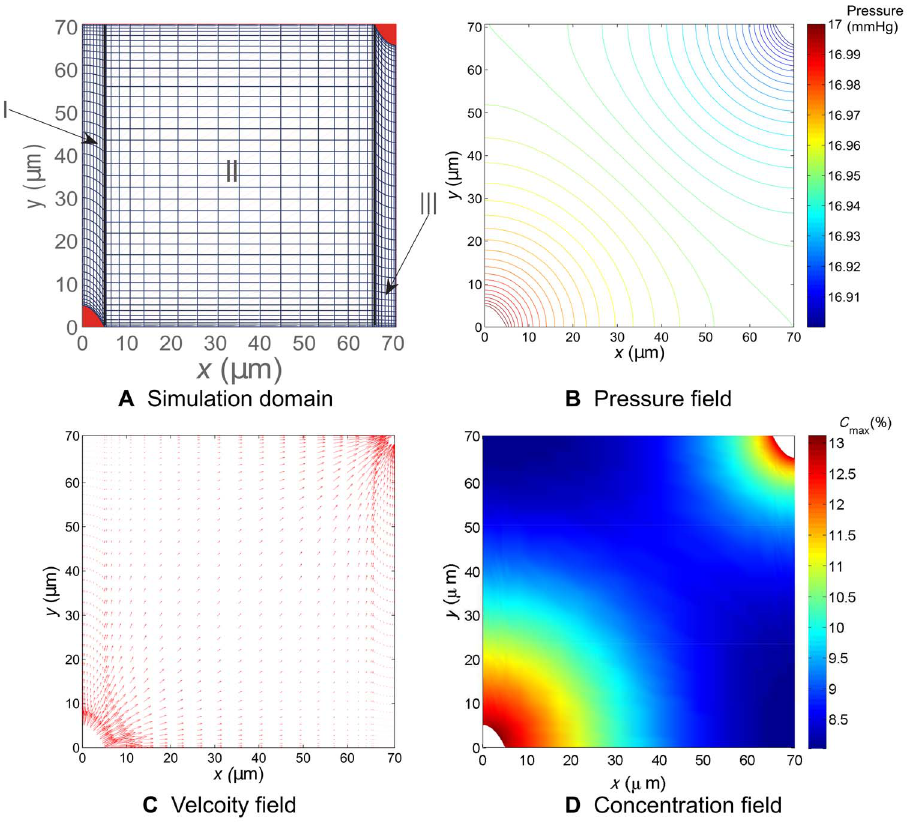
Figure 2. Illustration of the simulation domain and the computed pressure, velocity and concentration fields. Subfigure A illustrates sub-domains I, II, and III, and their meshes for G ~ 100 m m. Subfigures B and C are the computed pressure and velocity fields, respectively. D. The concentration distribution for G ~ 100 m m at 100 min.